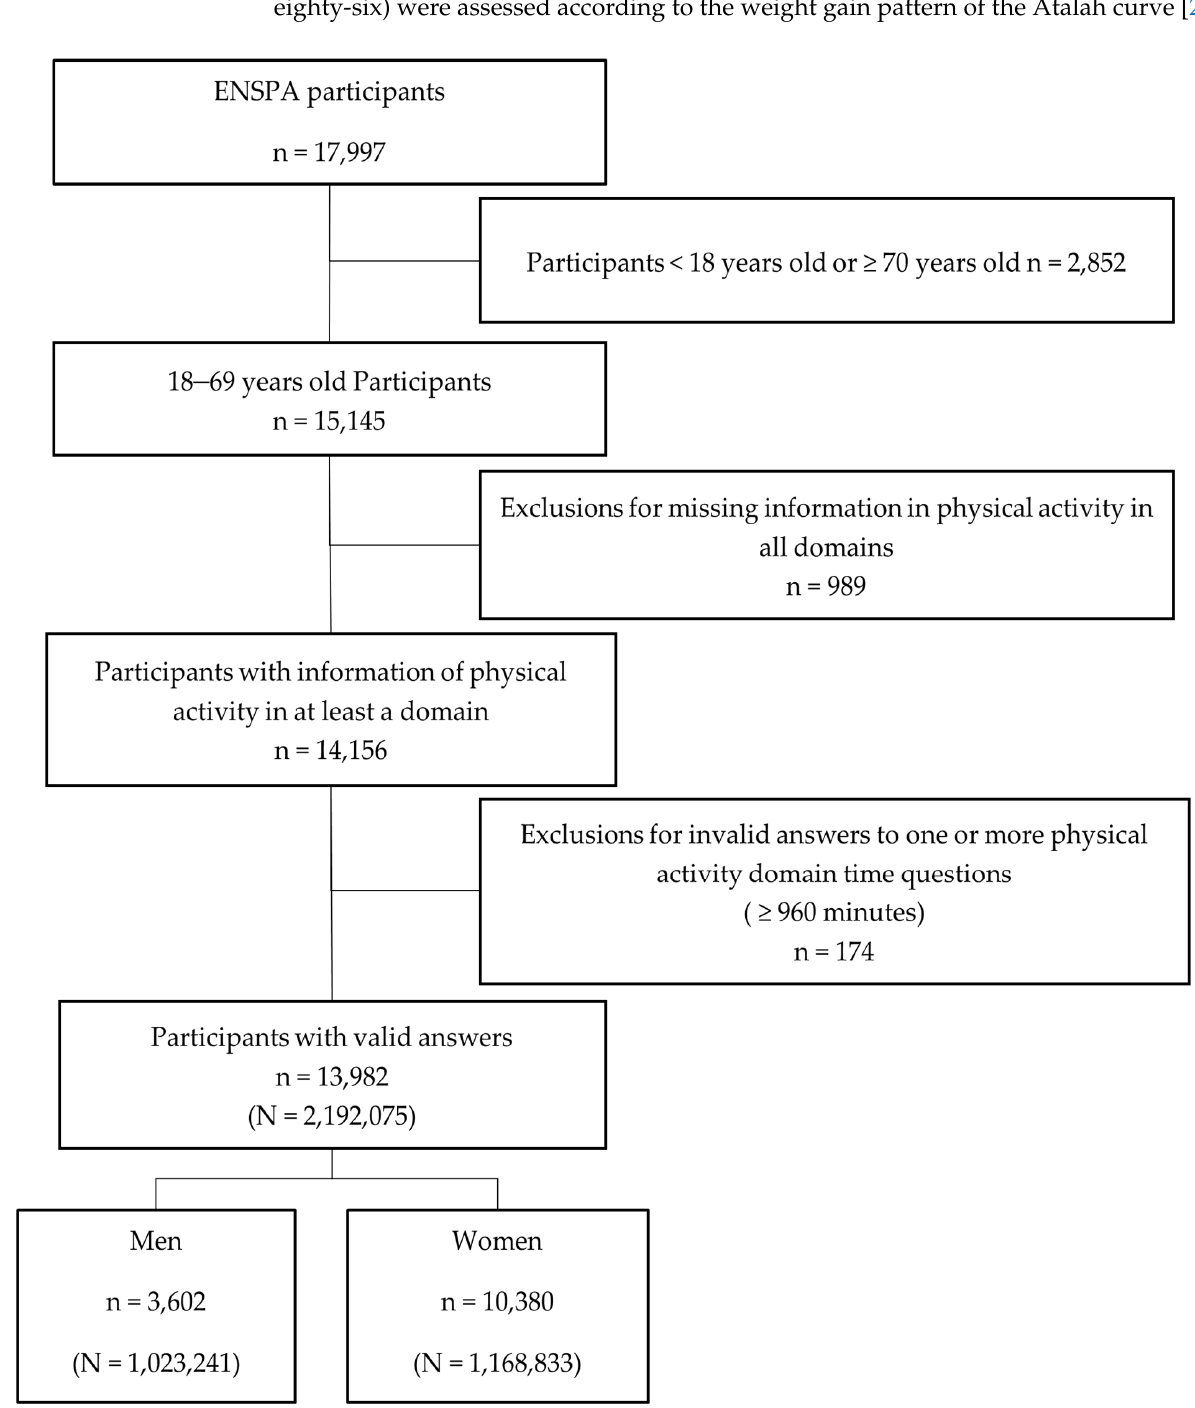
Figure 1. Flowchart summarising the exclusion and inclusion criteria for the study population and weighted frequencies of the study participants.